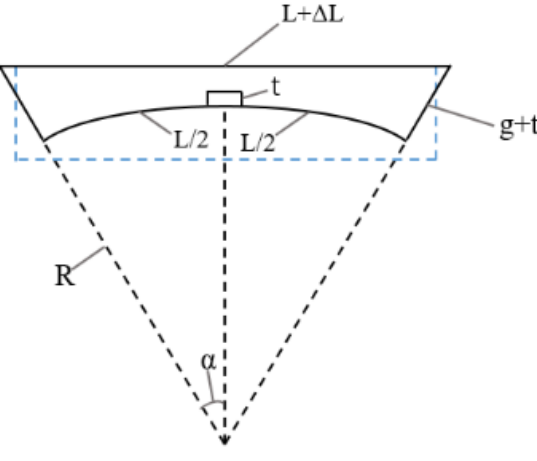
Figure 3. 2-D model of the double-clamped beam under the bending condition.